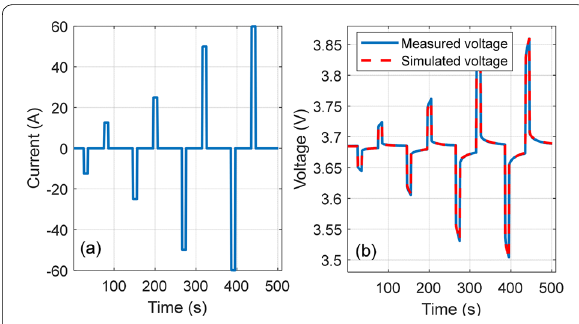
Figure 4 Current and voltage at SOC Measured voltage and simulated voltage based on